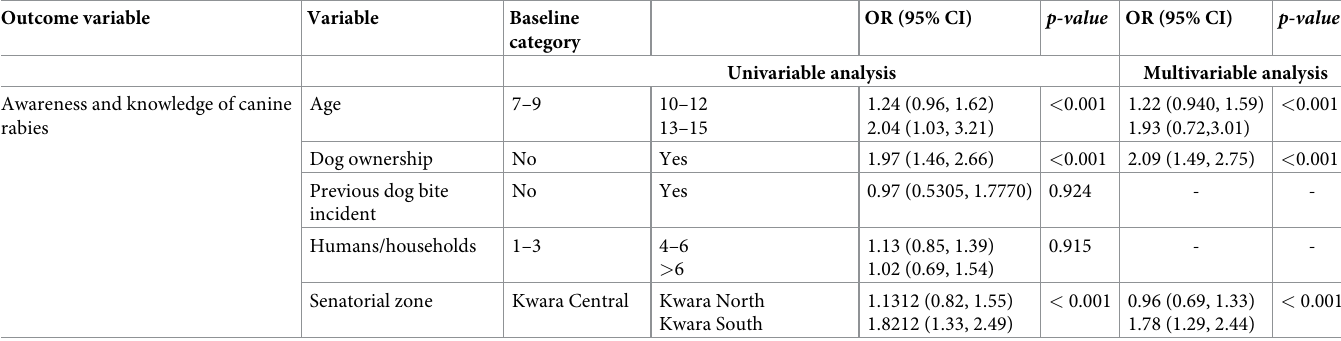
Table 4. Univariable and multivariable logistic regression analysis of demographic variables that affected the awareness of canine rabies among pupils under 15 years in Kwara state. Outcome